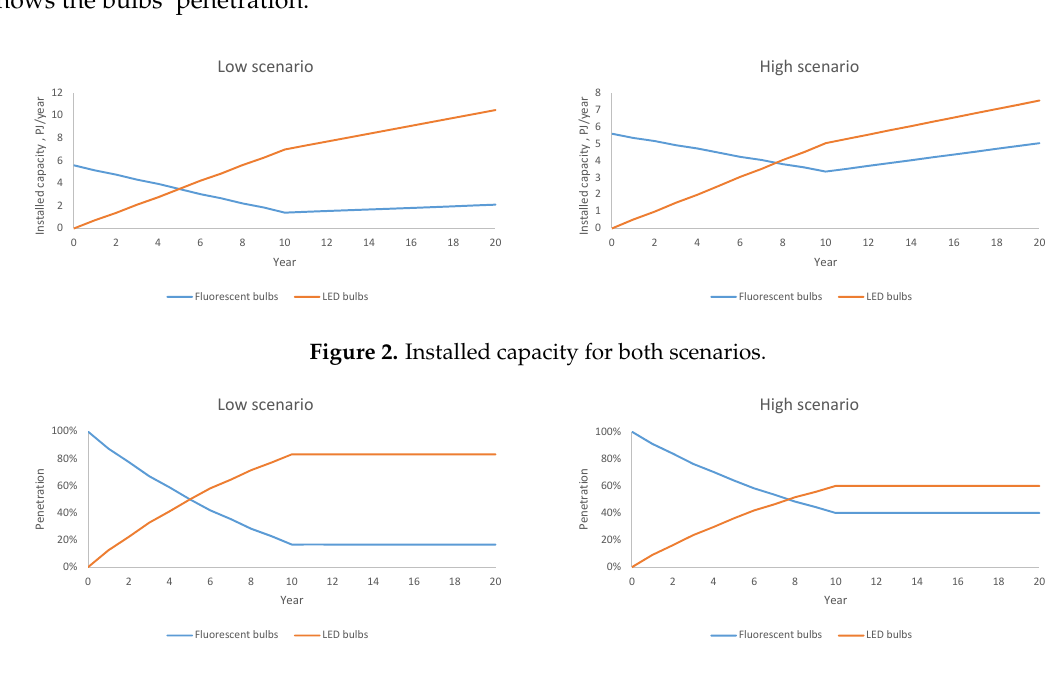
Figure 3. Bulbs’ penetration for both